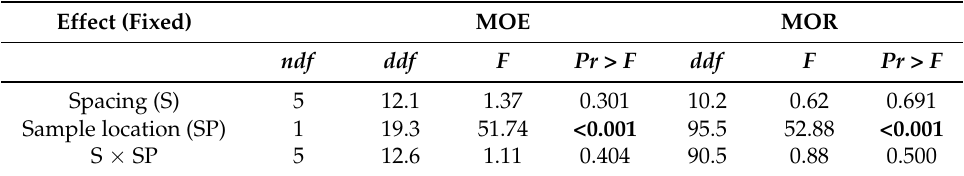
Table 5. Analysis of variance (ANOVA) results for jack pine modulus of elasticity (MOE) and modulus of rupture (MOR) 25 years following planting in eastern Canada. ndf : numerator degrees of freedom, ddf : denominator degrees of freedom; calculated using the Kenward-Roger method. Bold indicates significance ( p ≤ 0.05)